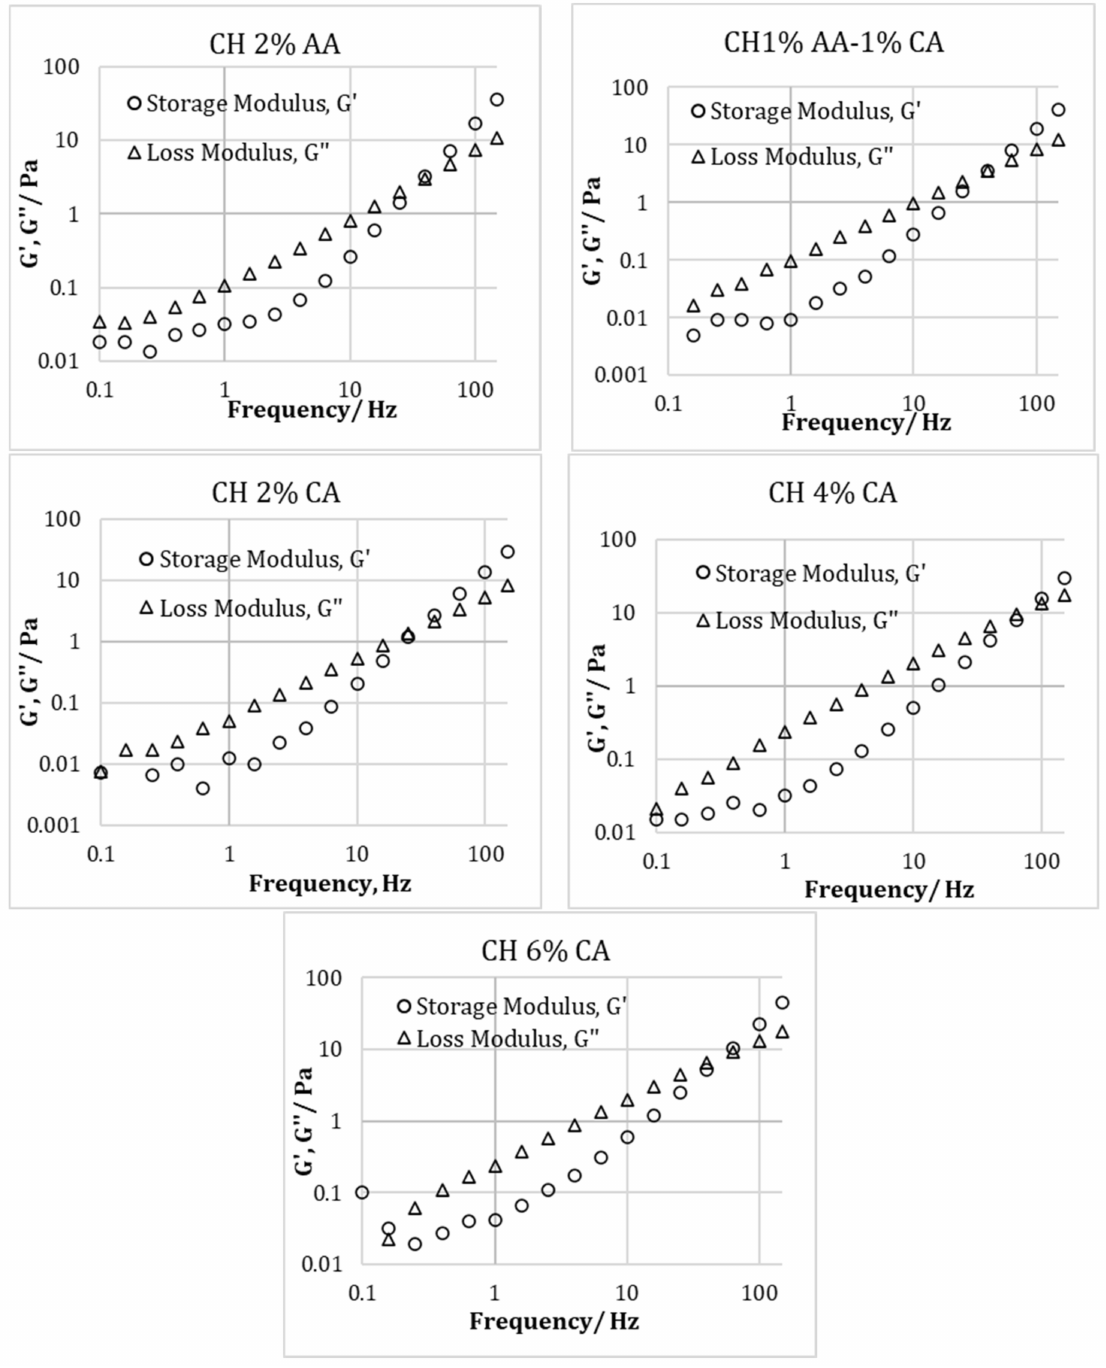
Figure 4. Relationship between Storage modulus (G (cid:48) ) and loss modulus (G (cid:48)(cid:48) ) vs. angular frequency from oscillatory frequency sweep of chitosan solution prepared using acetic acid (2% v / v ) and citric acid (2, 4, and 6% w / v